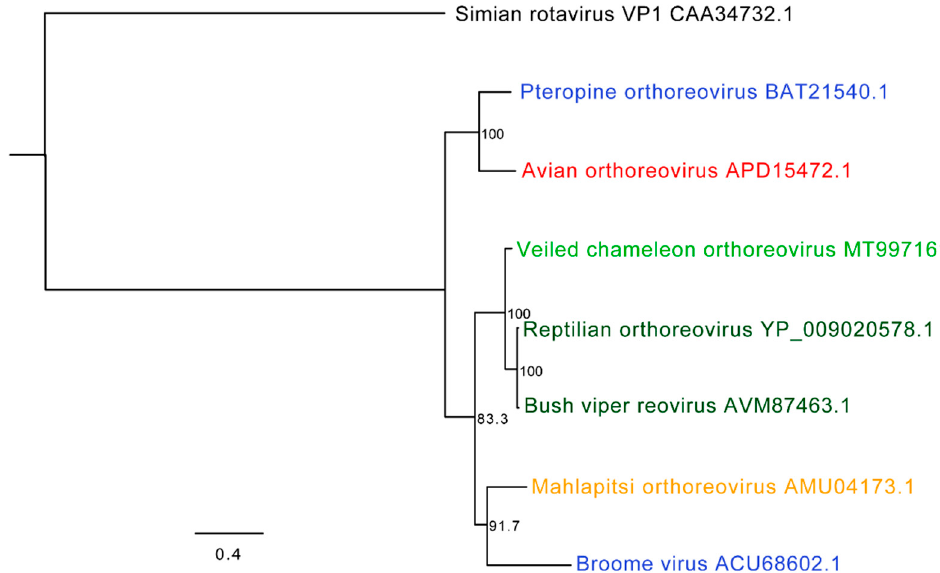
Figure 6. Phylogenetic tree of veiled chameleon orthoreovirus and orthoreoviruses of reptiles, mammals, and birds. The amino acid sequences of L3 segments (which encode the RNA-dependent RNA polymerase) were aligned and a phylogenetic tree constructed. Veiled chameleon orthoreovirus (light green) was compared to known reoviruses found in snakes (reptilian orthoreovirus and bush viper reovirus; dark green), bats (Broome virus and pteropine orthoreovirus; blue), bat flies (Mahlapitsi orthoreovirus; orange), and birds (avian orthoreovirus; red). The VP1 protein (RNA segment 1 encoding the RNA-dependent RNA polymerase) of the Simian rotavirus strain SA11 (black) was used as the outgroup. GenBank accession numbers are included to the right of the virus name. Maximum likelihood tree constructed using PhyML, LG substitution model, and 1000 bootstrap replicates; bootstrap values (percent) represented at each